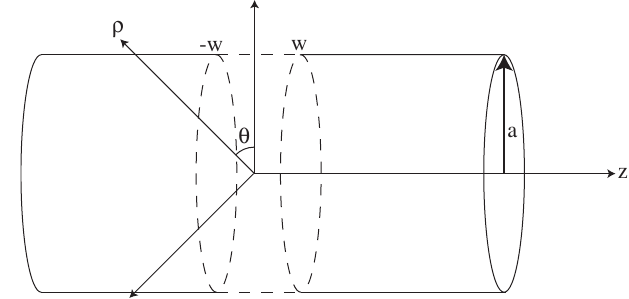
FIG. 1. The gap in the thin metal chamber and the cylindrical coordinate system ( (cid:1); (cid:2); z